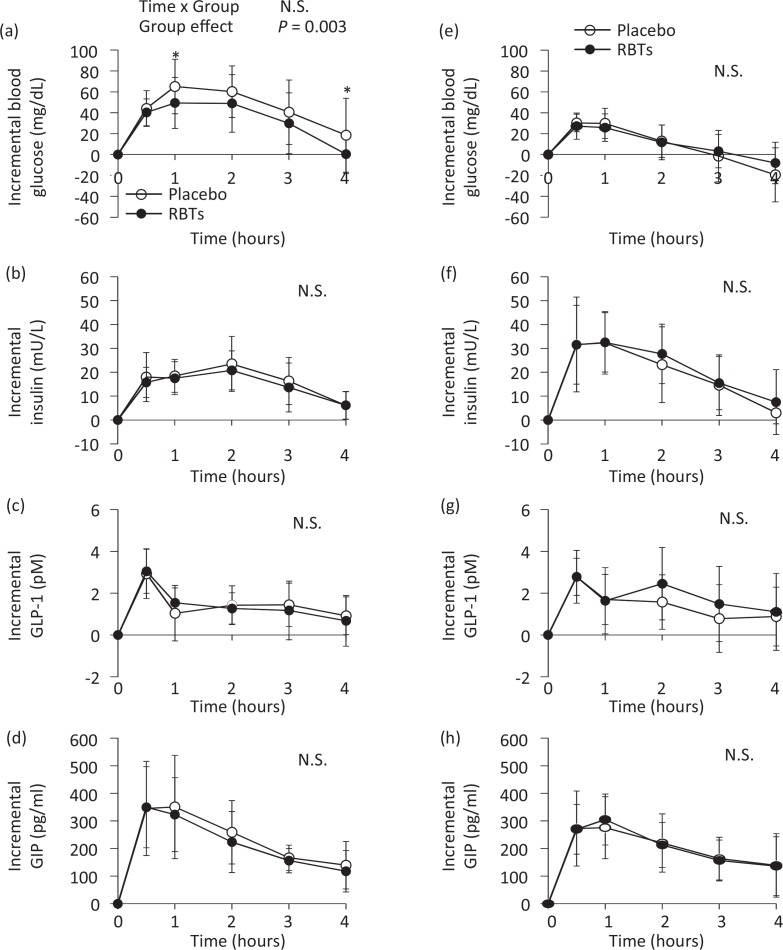
Postprandial changes in blood variables after rice bran triterpenoid (RBT) consumption in subjects with higher (a–d, n = 8) and lower (e–h, n = 11) postprandial incremental blood glucose levels at 2 h. Blood glucose (a, e), insulin (b, f), active glucagon-like peptide-1 (GLP-1) (c, g), and glucose-dependent insulinotropic polypeptide (GIP) (d, h) after the consumption of placebo (○) and RBTs (●) in subgroups comprising subjects with higher (>32.8 mg/dL; i.e. average of all subjects) or lower (<32.8 mg/dL) postprandial incremental blood glucose levels at 2 h after the placebo meal. Data are expressed as means and standard deviations, which are represented by vertical bars. A two-way repeated analysis of variance was used to compare changes over time and between the groups. Asterisks indicate the probability of random differences between groups: *P<0.05 indicates a significant difference between groups (Bonferroni test).